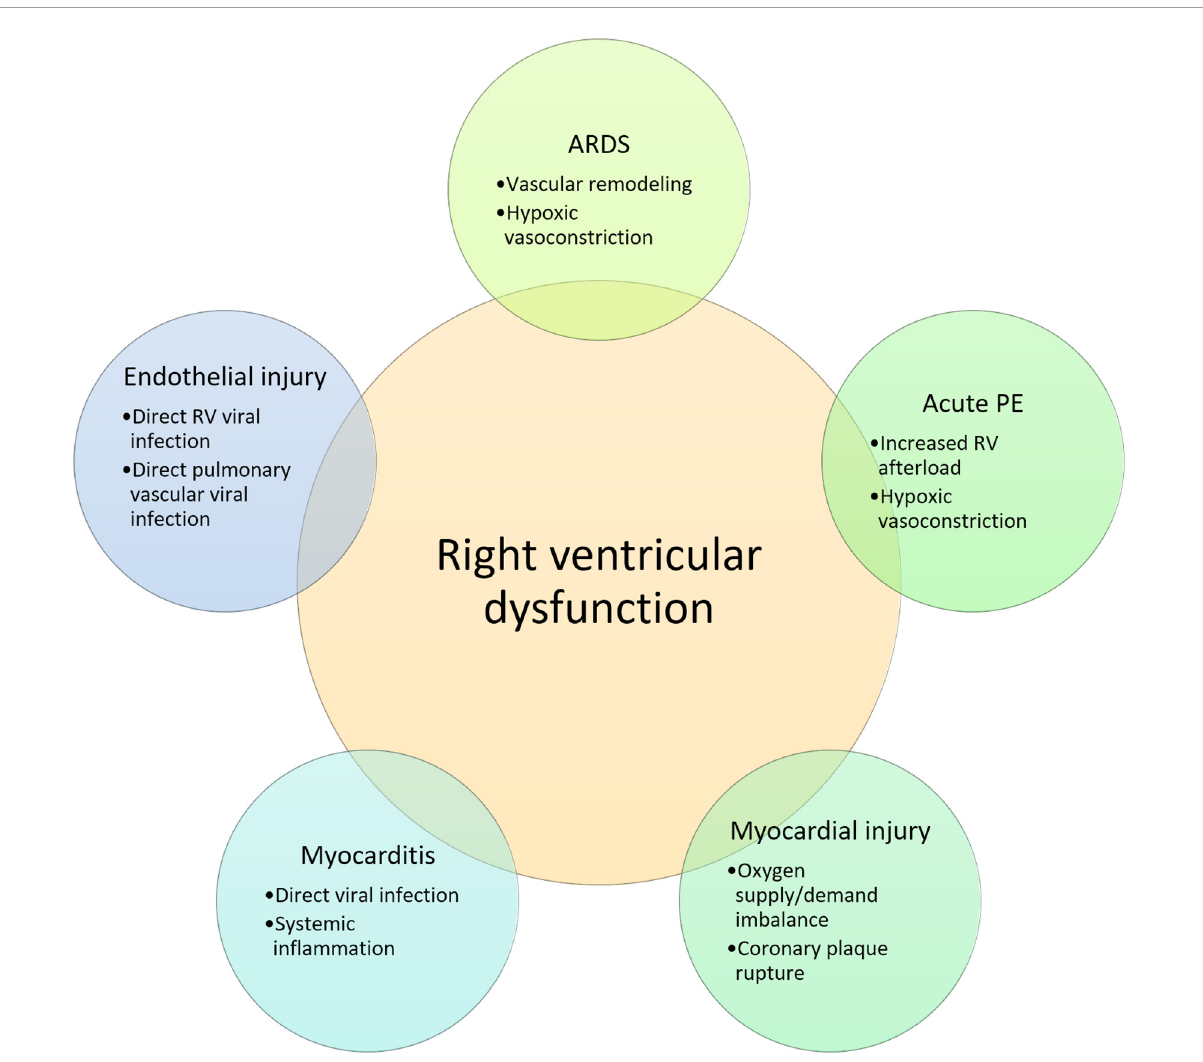
FIGURE1 Potential mechanisms of right ventricular dysfunction in COVID-19. RV, right ventricular; ARDS, acute respiratory distress syndrome; PE, pulmonary embolism; IL,